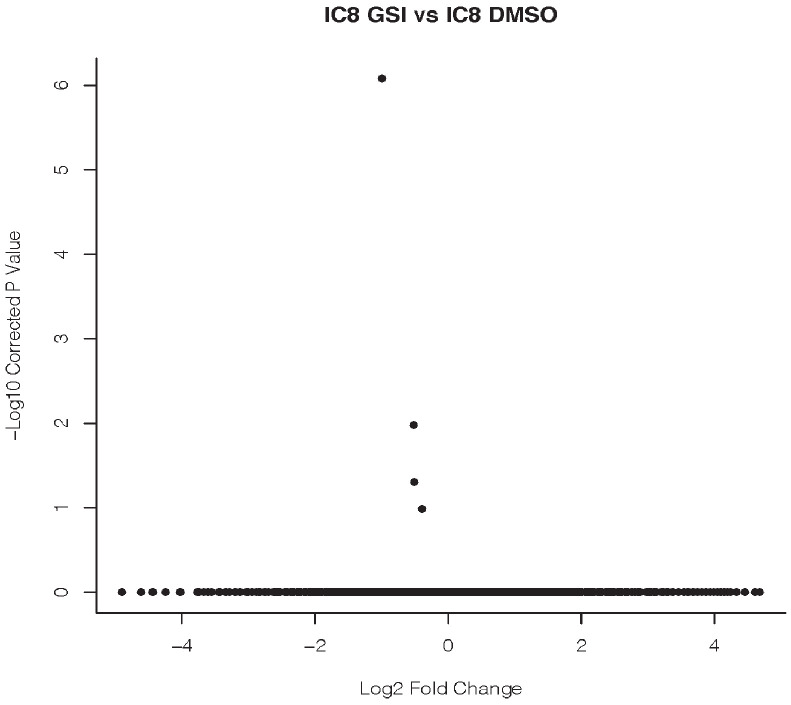
GSI treatment has little effect on gene expression in IC8 squamous carcinoma cells.Duplicate cultures of IC8 cells were treated with GSI or vehicle (DMSO) for 24 hr and transcript abundance was assessed by RNA-seq in two biological replicates. A volcano plot shows no differentially expressed genes using cutoffs of adjusted p-value<0.0001 and log2 fold change >1.